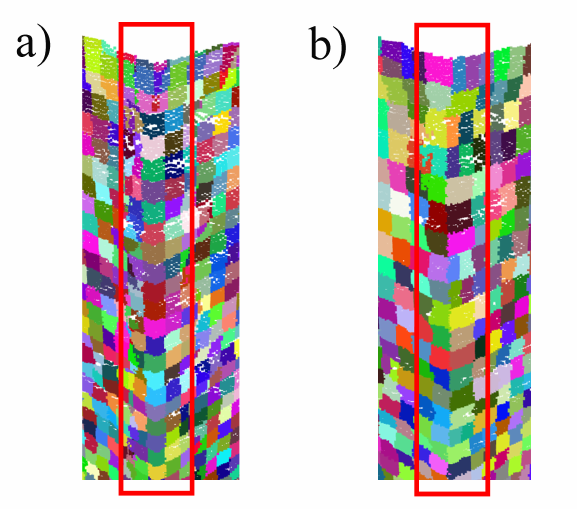
Figure 2: Point cloud partitioning into cellular units along a building corner with voxels (a) compared to ball-tree